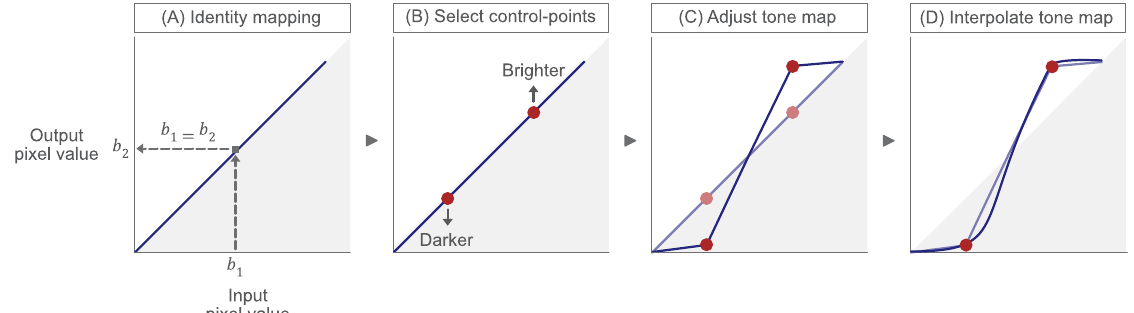
Figure 2. A diagram of tone map creation and interactive manipulation: ( A ) an input to output ‘identity’ mapping, ( B ) selection of control-points to modify the mapping ( C , D ) a smooth interpolation to create the final tone